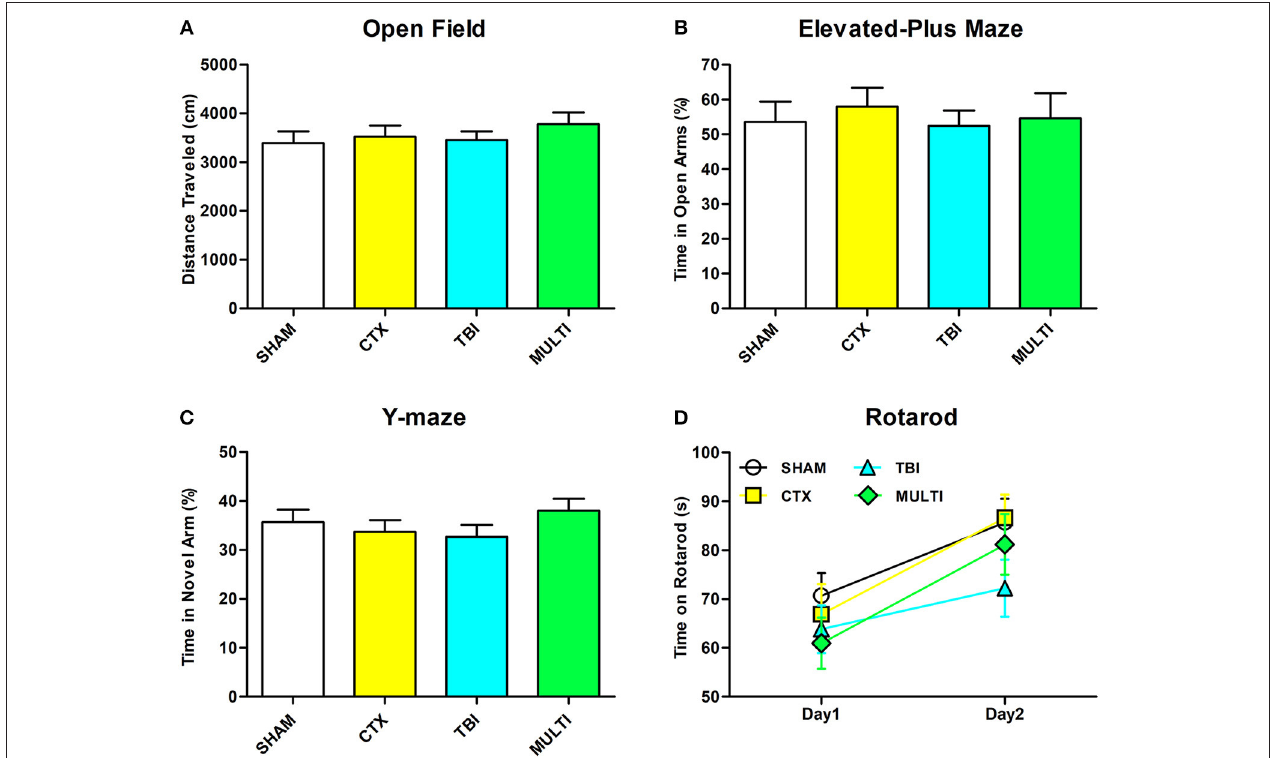
FIGURE 6 | There were no significant differences between the groups on any of the behavioral measures. (A) Distance traveled in open field. (B) Time spent in open arm of the elevated plus maze. (C) Time spent in the novel arm of the Y-maze. (D) Time spent on rotarod.